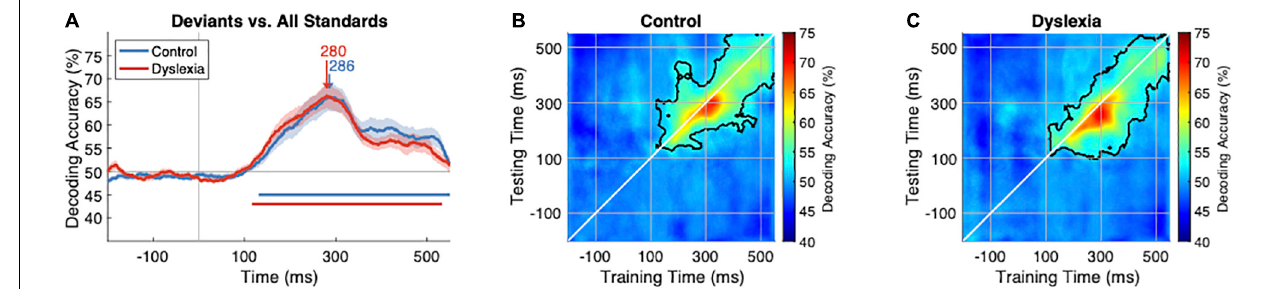
FIGURE 2 | Standard-vs.-deviant decoding is similar in Control and Dyslexia. (A) Time course of decoding accuracy averaged over n = 24 Control (blue) and n = 24 Dyslexia (red) participants. For each participant separately and at each time point independently, a classifier was trained to distinguish deviant trials from standard trials, where deviants were the 1st tokens in a train and standards were the 2nd, 3rd, 4th, 5th, and 6th tokens. Data from all trials were included, so there were no stimulus differences between deviants and standards. Standard-vs.-deviant decoding is significantly above chance after 100 ms, as indicated by the horizontal lines in corresponding colors, and reaches its peak accuracy, on average, 282 ms after sound onset. (B,C) Temporal-generalization matrices averaged within the Control and Dyslexia groups. On the diagonal (white line) is the traditional decoding analysis, in which a classifier is trained and tested at each time point [corresponding to (A) ]. Off the diagonal are decoding accuracies for classifiers trained at one time point ( x -axis) and tested at every other time point ( y -axis). Regions of significantly above-chance temporal generalization are outlined in